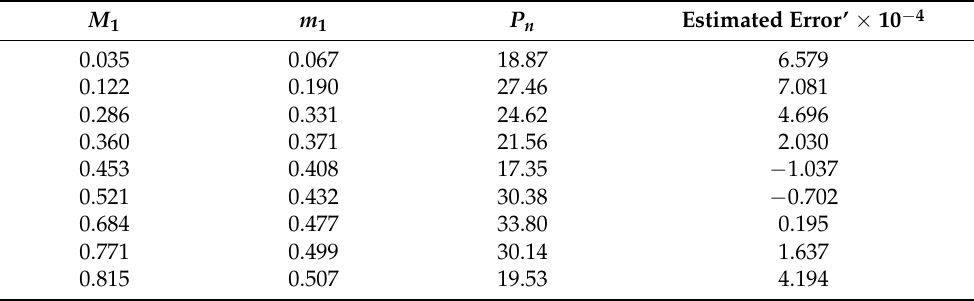
Table 6. The input data for medium conversion and r 1 = 0.02 and r 2 = 0.40 (MC1).